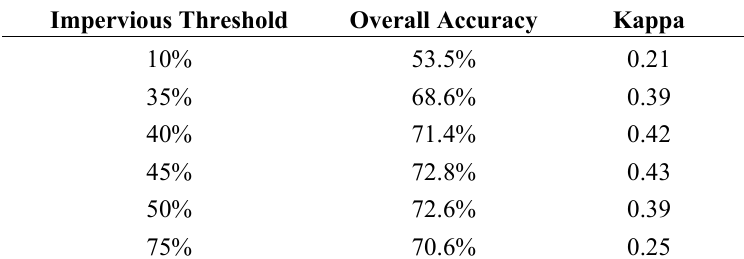
Table 3. Overall accuracy and kappa of Roanoke’s NLCD IS dataset at varying thresholds of percent